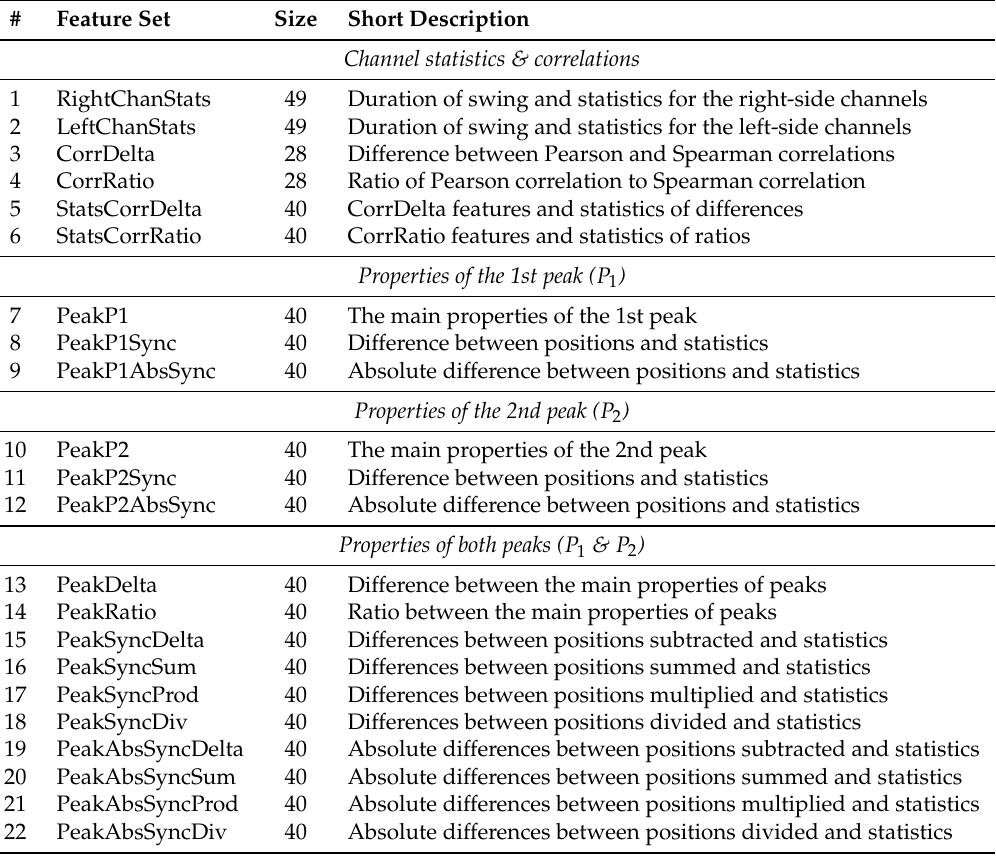
Table 1. Descriptions of feature sets. Note: the size count does not include